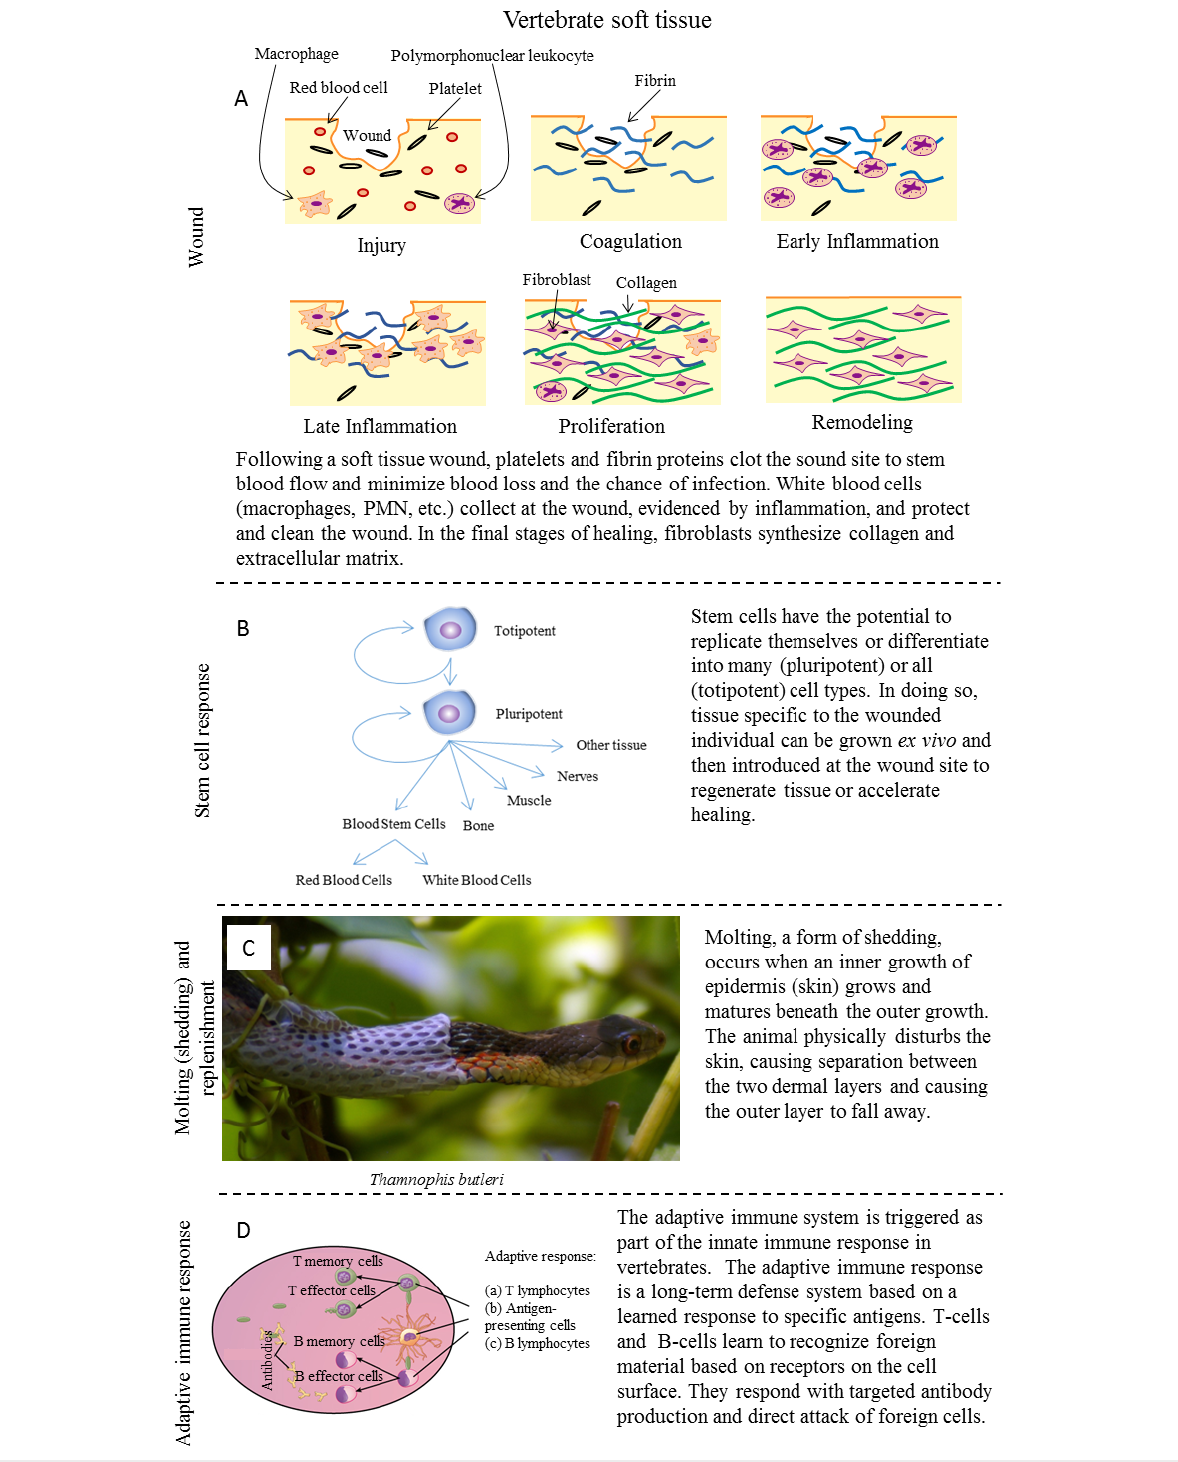
Figure 4: Types of healing in vertebrate soft tissue is shown, including (A) wounds, (B) stem cell differentiation, (C) shedding, and (D) the adaptive immune system response. (A) Soft tissue wounds elicit a short-term clotting response followed by a long-term cellular signaling response ending with remodeling of the damaged tissue. Adapted with permission from [54], copyright 2003 Cambridge University Press. (B) Stem cells, the original cells that all other cells develop from, offer unique healing opportunities through replication and differentiation. (C) Some vertebrates periodically shed their epidermal tissue for growth or seasonal changes, revealing new tissue beneath. Reproduced from [55], copyright 2009 Goellnitz, under CC-BY-NC 2.0 license (https://creativecommons.org/licenses/by-nc/2.0/). (D) The adaptive immune system, unique to vertebrates, utilizes a stored “memory” response to fighting and removing harmful microbes. Adapted from